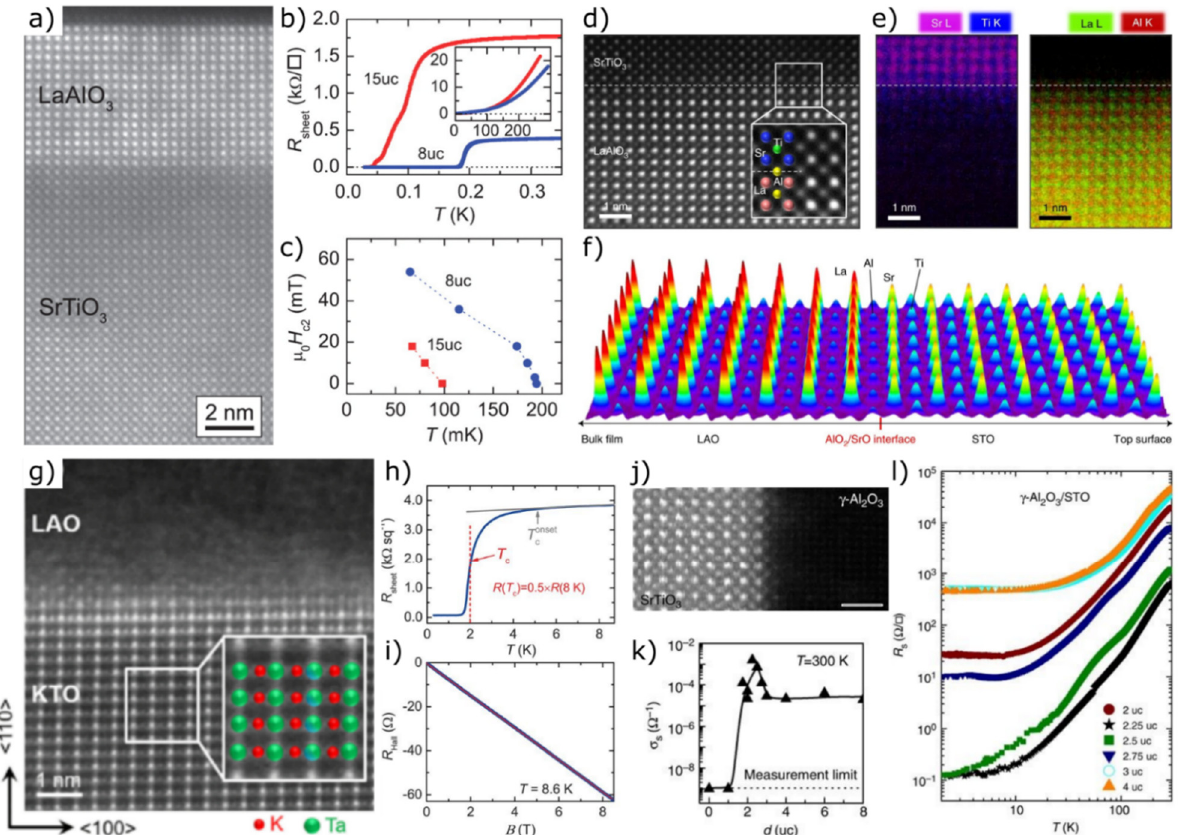
Figure 8. ( a ) HAADF image of the coherent interface between a 15-unit-cell-thick LaAlO 3 film grown on SrTiO 3 . ( b , c